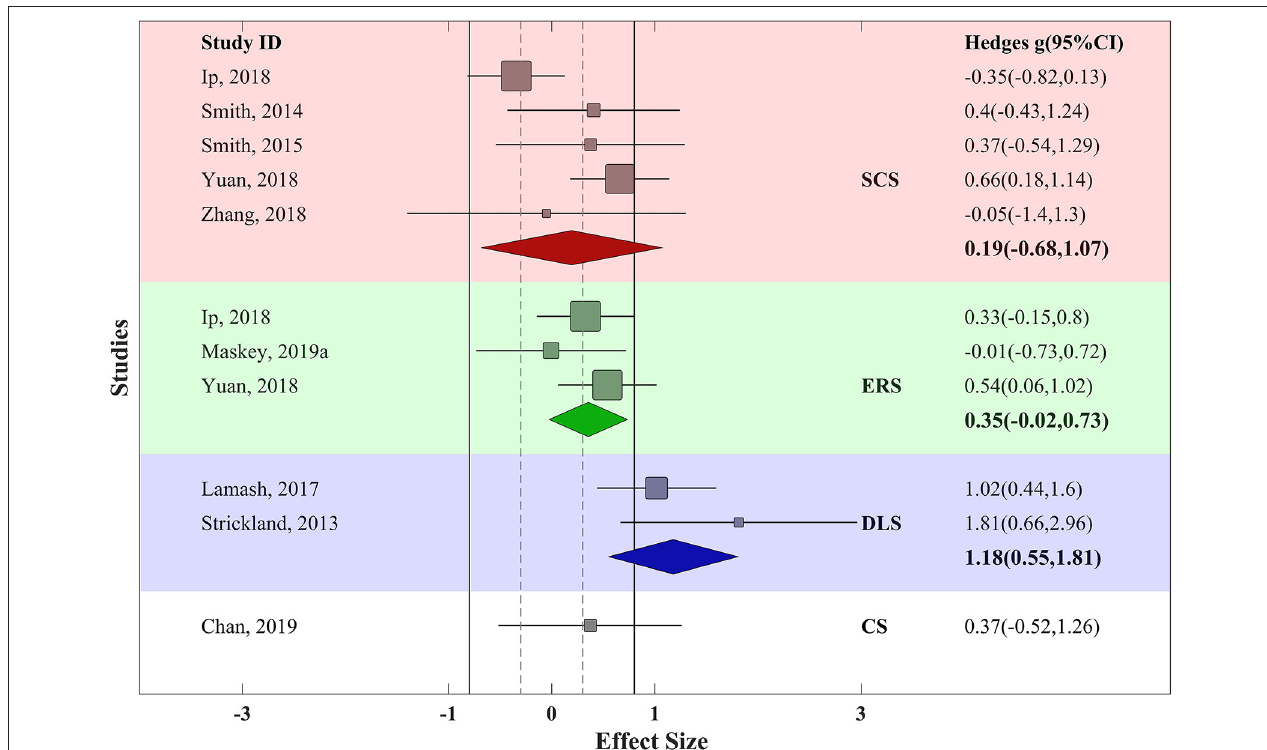
FIGURE 4 | Funnel plot for VR training effectiveness of both uncontrolled and controlled trials with pseudo 95% confidence interval. Red area represents SCS; green − area represents ERS; blue area represents DLS; and yellow area represents CS. Solid vertical lines represent strong effect size boundary ( g 0.8 and 0.8), and = − dashed vertical lines represent weak effect size boundary ( g 0.3 and 0.3). Filled and empty circles represent Hedges g value of uncontrolled and controlled trials, = − respectively. Solid lines represent g with 95% confidence interval of uncontrolled trials and dashed lines represent g with 95% confidence interval of controlled